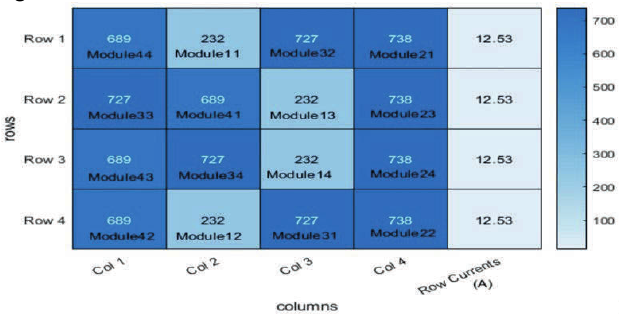
Fig. 5. Final configuration of panels.